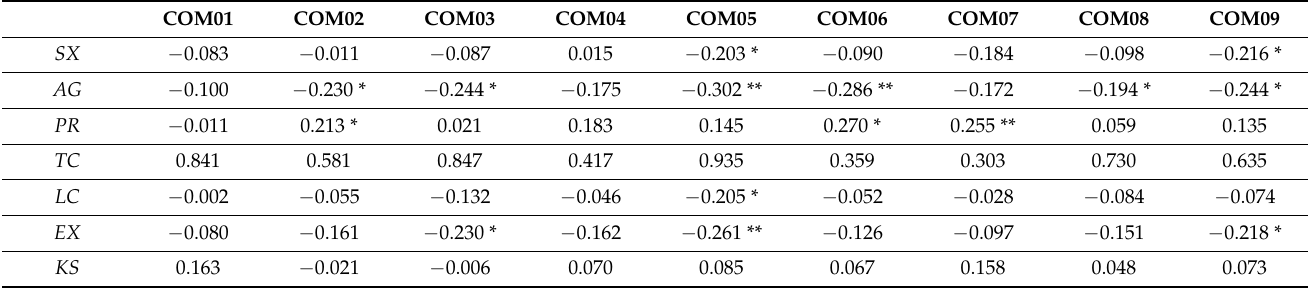
Table A5. Spearman correlation matrix: knowledge of communication tools.